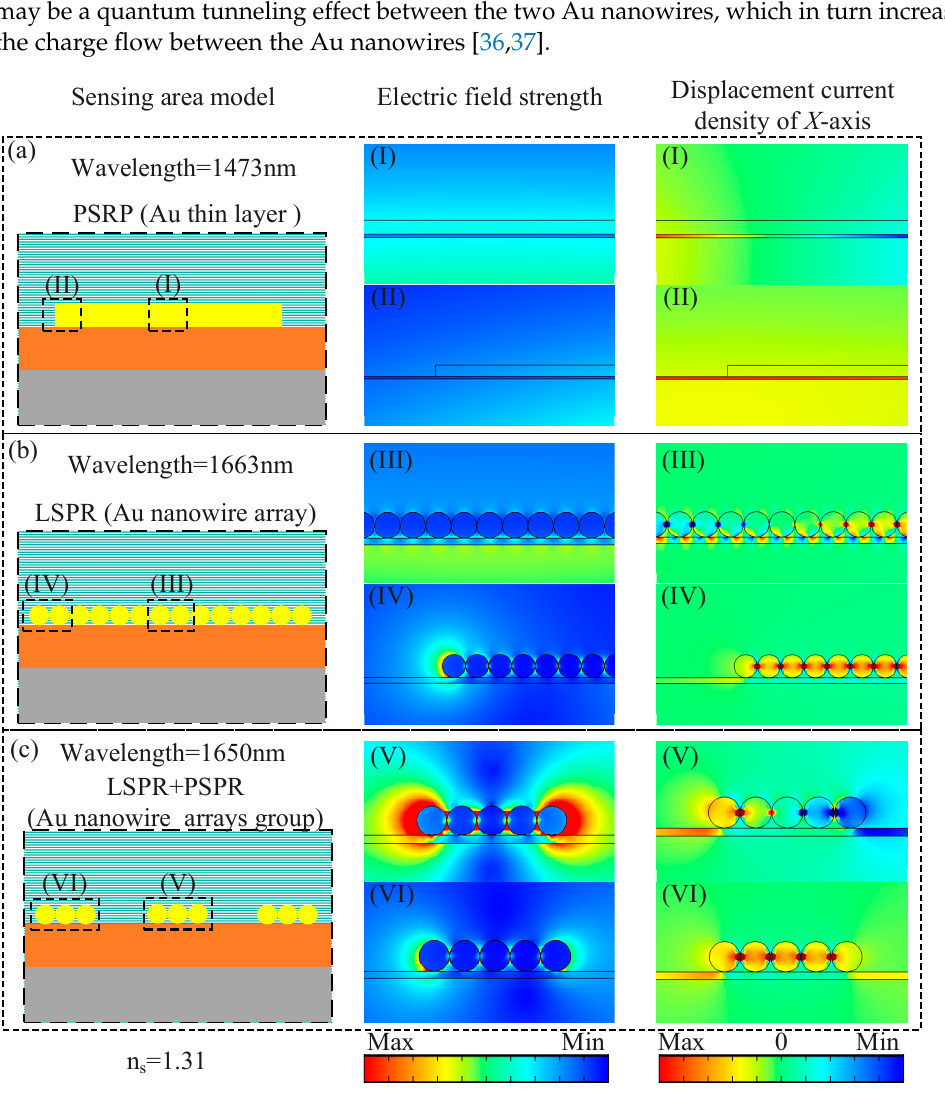
Figure 4. Simulation analysis of sensing area. ( a ) PSPR sensing principle; ( b ) LSPR sensing principle; ( c ) Au nanowire groups array sensing principle.